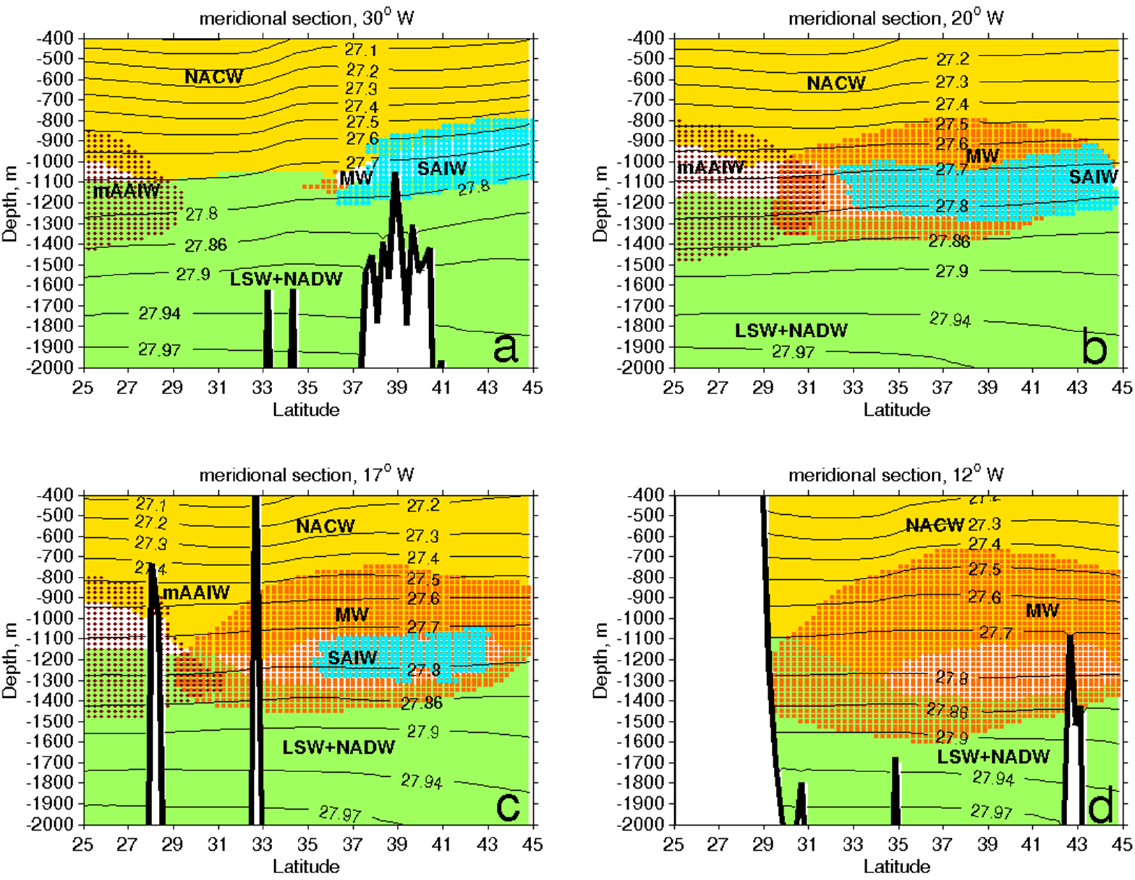
Figure 11. Distribution of water masses, the contribution of which exceeds 25%, along meridional sections (a) 30 ◦ W, (b) 20 ◦ W, (c) 17 ◦ W, (d) 12 ◦ W. Yellow is NACW, green – LSW and NADW, orange – MW, cyan – SAIW, brown – mAAIW. Note the overlap of different water masses in some areas, since at any given point more than one water mass may have contribution over